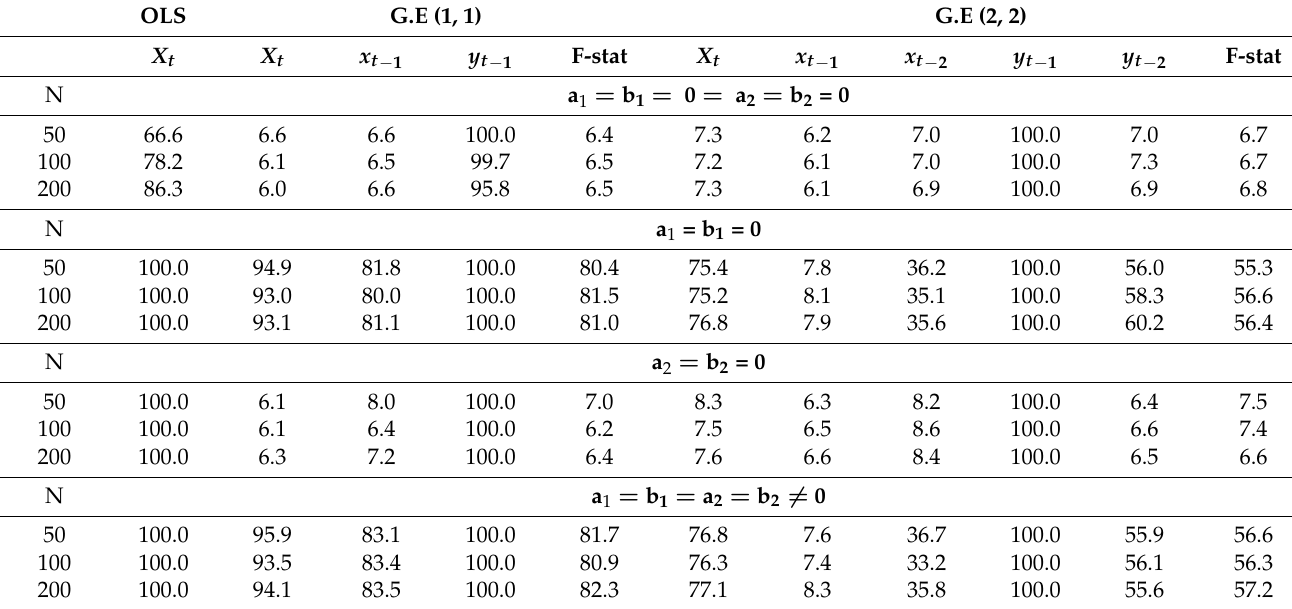
Table 1. Probability of spurious regression with OLS and Ghouse equation.